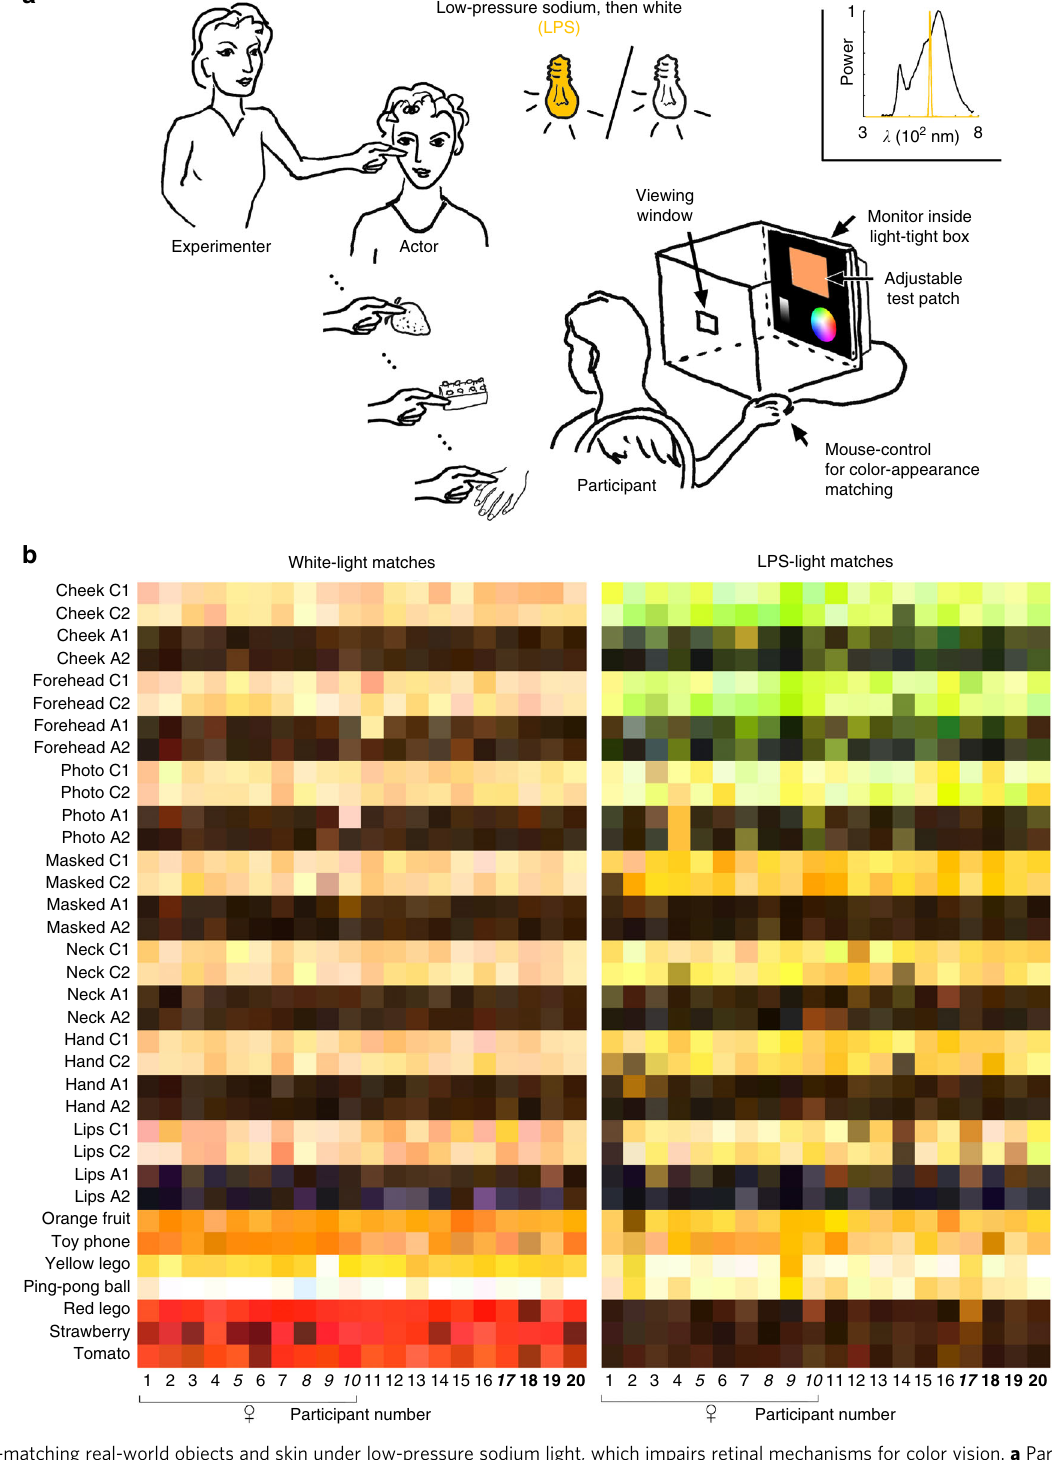
Fig. 1 Color-matching real-world objects and skin under low-pressure sodium light, which impairs retinal mechanisms for color vision. a Participants ( N = 20) used a computer to match the color of real-world objects (items listed in panel b ) and skin (four female actors, 2 Caucasian, 2 African American), fi rst illuminated by low-pressure sodium light and then broad-band white light (inset shows illuminant spectra). Each participant was seated so that they could view the test stimuli shown to them by the experimenter, as well as a 2 × 2 cm viewing window in an otherwise light-tight box through which they could see a color-calibrated monitor (21.5-in. iMac computer, pixel resolution 1920× 1080). Participants used a mouse to navigate a color-space disc and lightness strip, setting the hue, brightness, and chroma of the test patch to make the color match. Photographs and spectral measurements of objects are given in Supplementary Fig. 1. b Color-appearance matches made by all participants for the 35 test stimuli. The swatches are rendered using the RGB values as matched on a calibrated monitor (white point: XYZ = 87.4, 100, 57.7). Participant information: average age 27.5 (range 19 – 33); 10 female; 12 Caucasian; four Asian (italics); three African American (bold); one South-East Asian (italic bold). Source data are provided as a Source Data fi